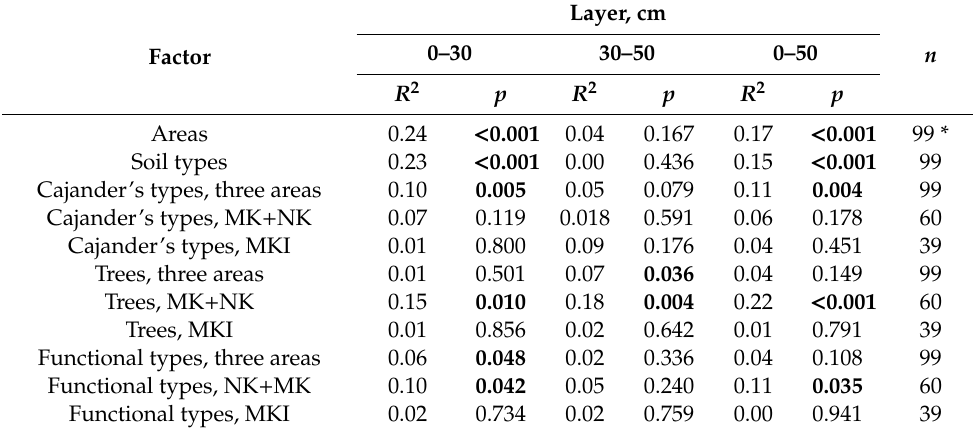
Table 1. One-way ANOVA of the main factors a ff ecting soil carbon